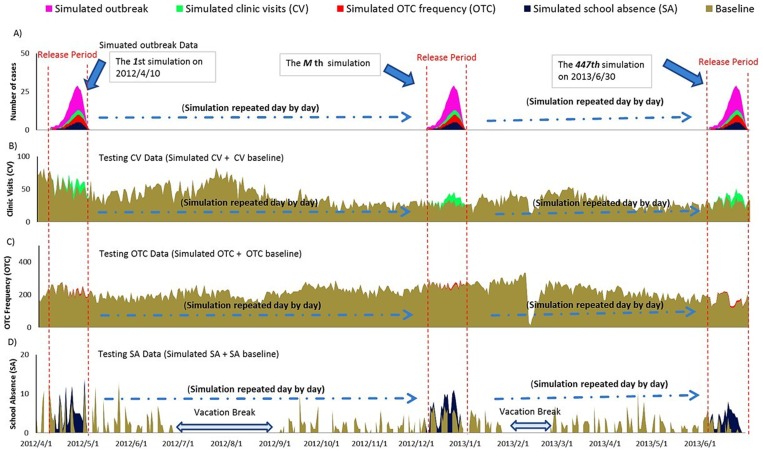
Generation of semi-synthetic testing datasets in six towns in Hubei, China, 2012/4/1–2013/6/30.A) Simulated Outbreak Data (generated by SEIR model) and converted syndromic data (generated by healthcare-seeking behaviors model); B) Testing CV Data (simulated CV + CV baseline); C) Testing OTC Frequency Data (simulated OTC + OTC baseline); D) Testing SA Data (simulated SA + SA baseline). The pink epidemic was one of the simulated outbreaks generated by the SEIR model. This could be converted into simulated clinic visits (green), simulated OTC drug purchase frequency (red), and simulated school absence (black), according to the healthcare-seeking behaviors model. The first simulated outbreak was released on 2012/4/10. Simulated syndromic data were superimposed onto corresponding baselines on the same release period (see B, C, and D). Every simulation released one outbreak to generate three testing datasets, including testing CV data, testing OTC data, and testing SA data. The simulation was repeated day by day during the whole surveillance period (2012/4/10–2013/6/30). Testing SA data on vacation breaks were defaulted as “0.” CV: clinic visits; OTC: over-the-counter; SA: school absence; SEIR: Susceptible – Exposed – Infectious – Recovered model.